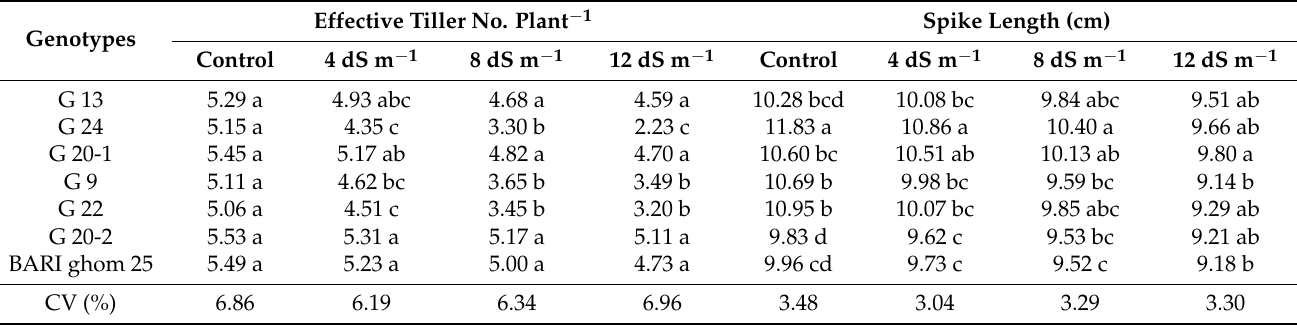
Table 2. Effective tiller number and spike length of wheat genotypes under different salinity